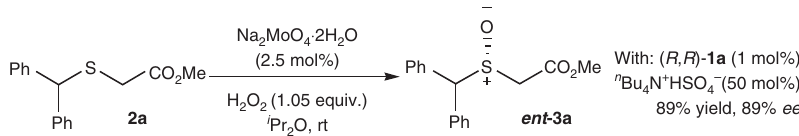
Figure 8 | Effect of achiral tetrabutylammonium cation. Evaluation of selectivity using 50mol% of n Bu 4 NHSO 4 as achiral ion-pairing reagent with 1mol% of chiral catalyst ( R , R )- 1a